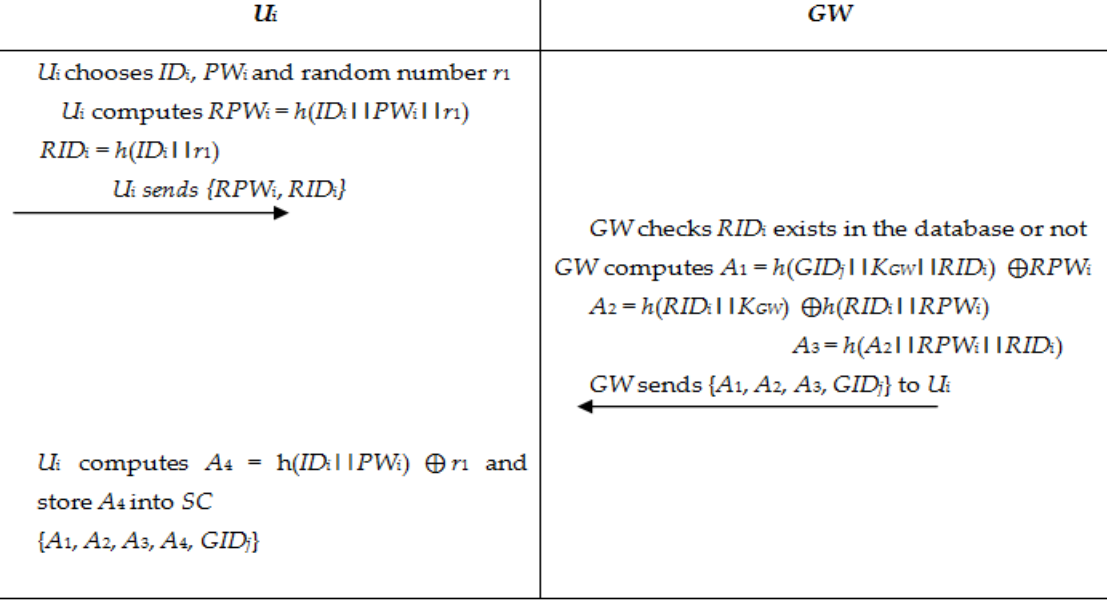
Figure 7. Registration phase between U i and